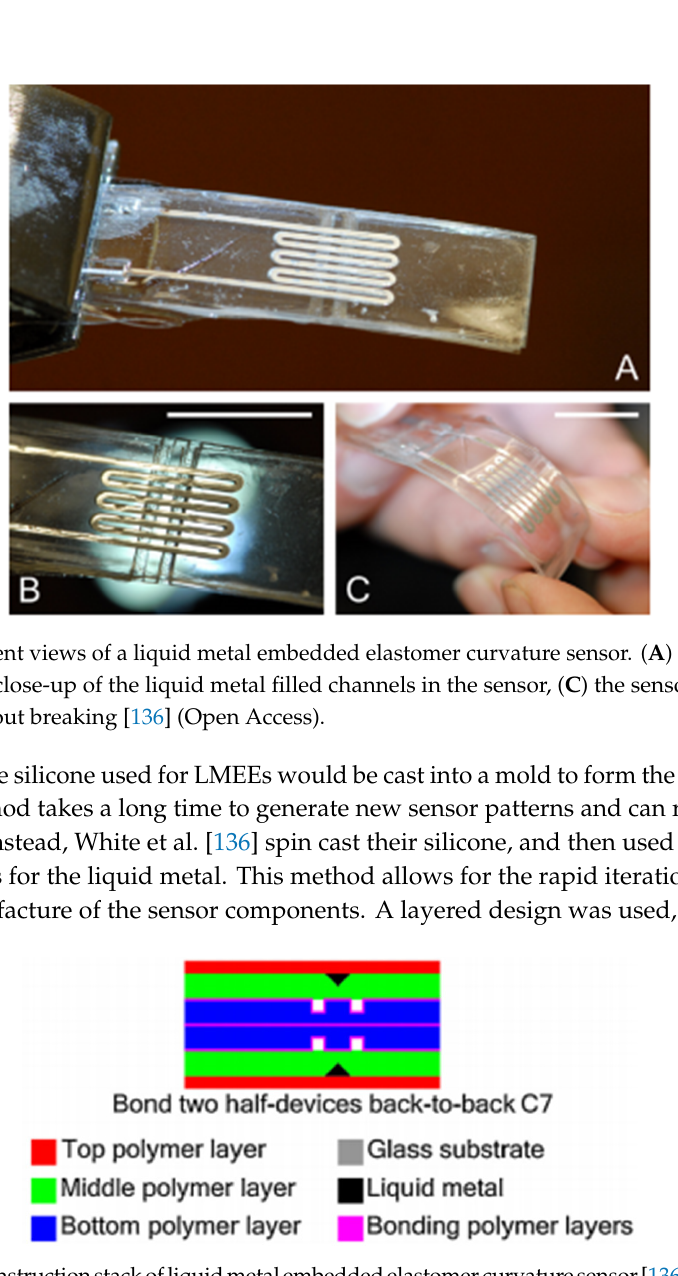
14 of 27 Figure 15. Experimental set-up of a reverse pneumatic artificial muscle (rPAM) [12] (Open Access). 5. Sensors Over the past four years sensing technology for soft robotics, the lack of which has delayed industrial and commercial adaptation, has been heavily researched [129]. There have been multiple research efforts exploring different curvature, tactile, and optical sensors for use with soft robotics yielding reliable sensors capable of a high degree of accuracy with minimal hysteresis [55,118,130]. Many of the studies emphasized the development of inexpensive, easily manufacturable sensors that can be integrated into flexible applications without affecting the performance of the stretching and deforming structure of the soft robots [33,85,131–133]. The primary avenues of recent research have been investigating liquid metal embedded elastic sensors, embedded magnetic sensors, semi- conductive polymer sensors, optical fiber curvature sensors, and even piezoelectric sensors [134,135].